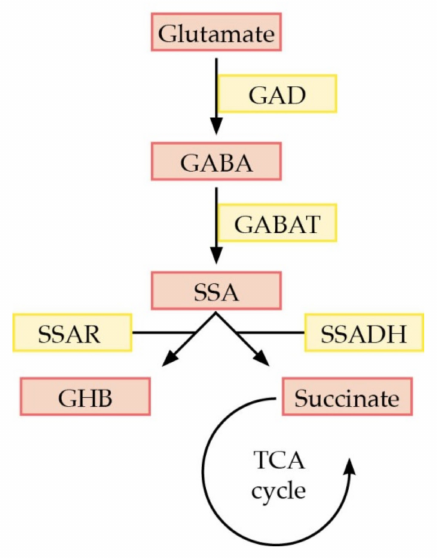
Figure 1. Metabolic pathway of γ -amino butyric acid (GABA)